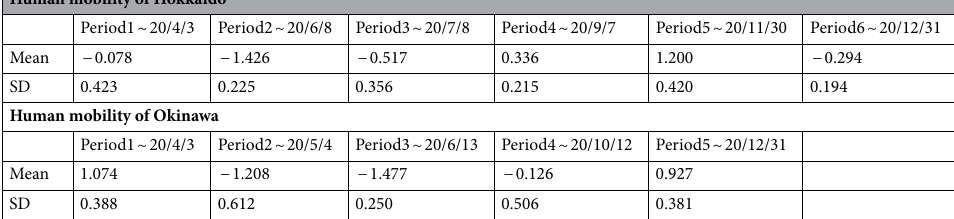
Table 3. Change point detection for infectious growth acceleration and inter-human mobility in Hokkaido and Okinawa. LocationMind xPop © LocationMind